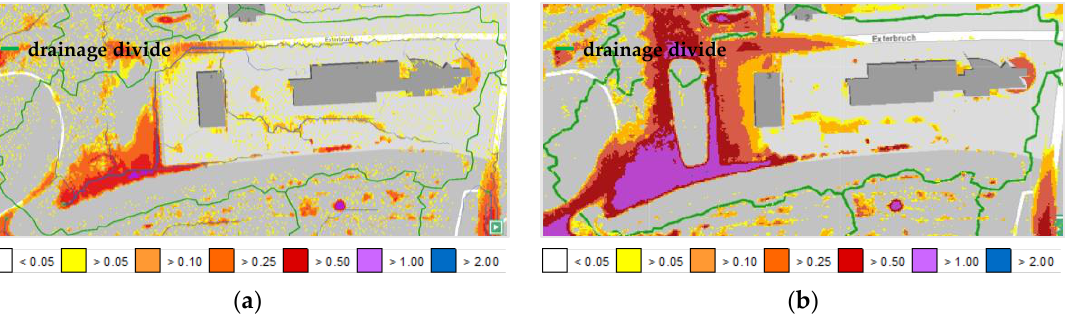
Figure 7. Predicted flood extent and depth after the precipitation: ( a ) reference flood map [30]; ( b ) simulation using an acceleration solver, and the SWMM manual roughness coefficient values.